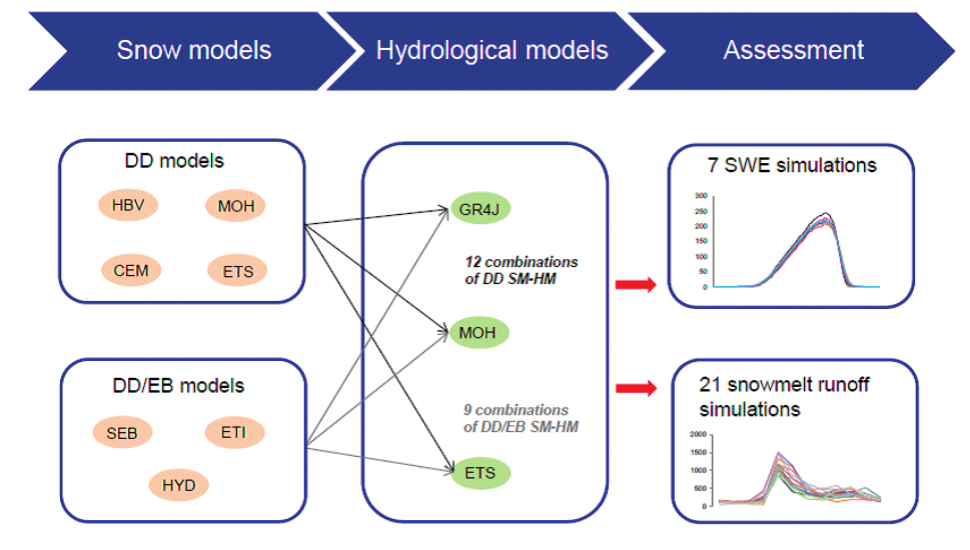
Figure 3. Schematic description of the multi-model approach used in this